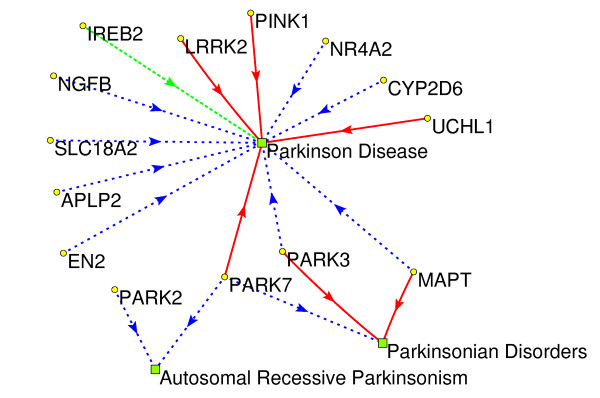
Etiologic semantic relations regarding Parkinson's disease extracted with NLP and filtered with the postprocessing procedure. Yellow circles represent genes. Green squares symbolize diseases. Arrowed lines in red (solid), light green (densely dotted), and blue (lightly dotted) represent CAUSE, PREDISPOSE, and ASSOCIATED_WITH semantic relations, respectively.